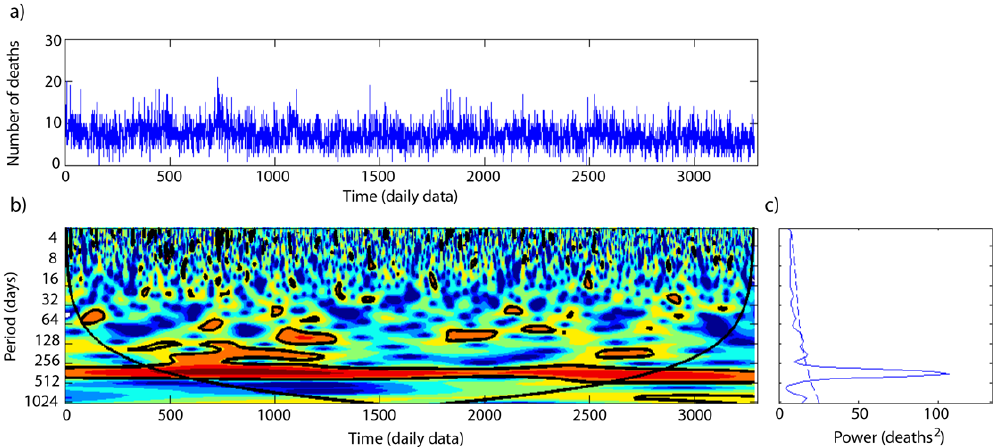
Fig. 1. Wavelet analysis for CVD 0–64 years group. (a) Time series. (b) Power wavelet spectrum. (c) Global wavelet spectrum. (d) Scale average time series for the following frequency bands: 3–4, 6–8, 12–16, 25–32, 32–64, 64–128, 128–256, 330–400, 500–600, 601–700 days.